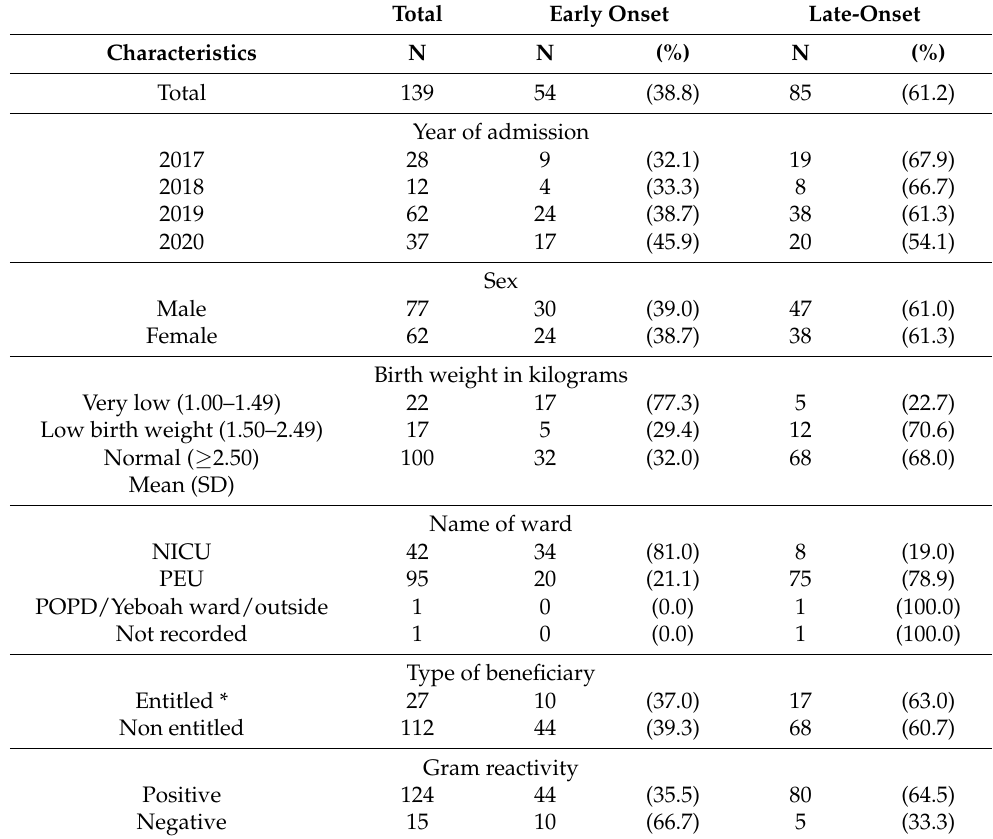
Table 2. Baseline characteristics of neonates with culture-confirmed sepsis, stratified by early and late-onset sepsis, at the 37 Military Hospital, Accra, Ghana (2017–2020). Total Early Onset Late-Onset